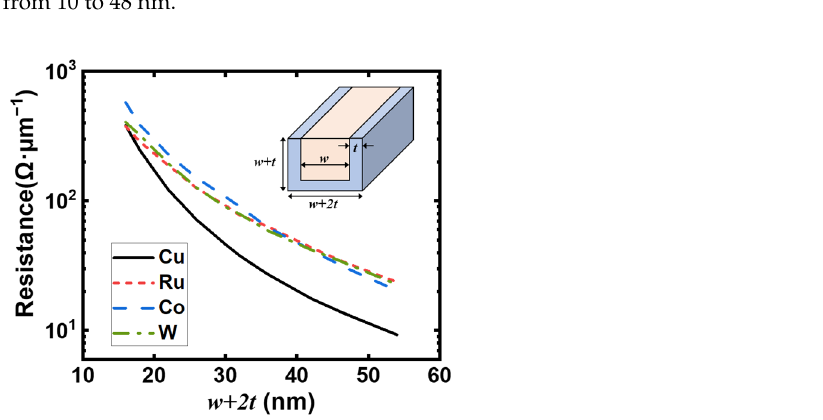
Figure 6. The scattering rate of GB and SR in ( a ) Cu, ( b ) Ru, ( c ) Co, and ( d ) W lines at electron energy levels of k B T /2 and 5 k B T . The linewidth varies from 48 down to 10 nm. It is worth noting that the GBS rate decreases with energy, and the SRS rate increases. The SRS rate is still one order of magnitude lower than the GBS rate at 5 k B T , where the electron distribution starts to be scarce. The reason is that electrons with higher energy are prone to be less affected by the potential energy of grain boundaries; however, the probability of a collision between hot electrons and the surface increases notably.